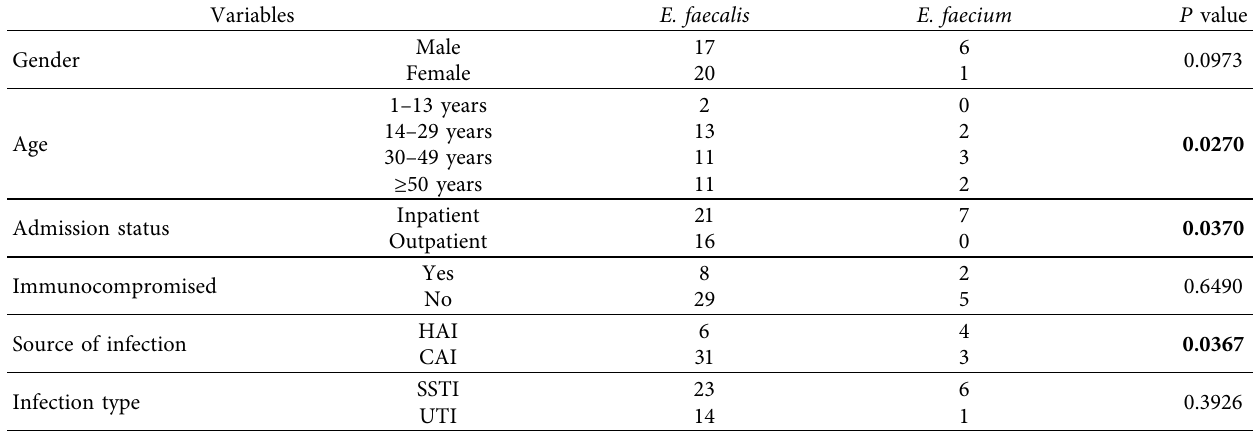
Table 1: Demographic and clinical characteristics of patients with E. faecalis / faecium